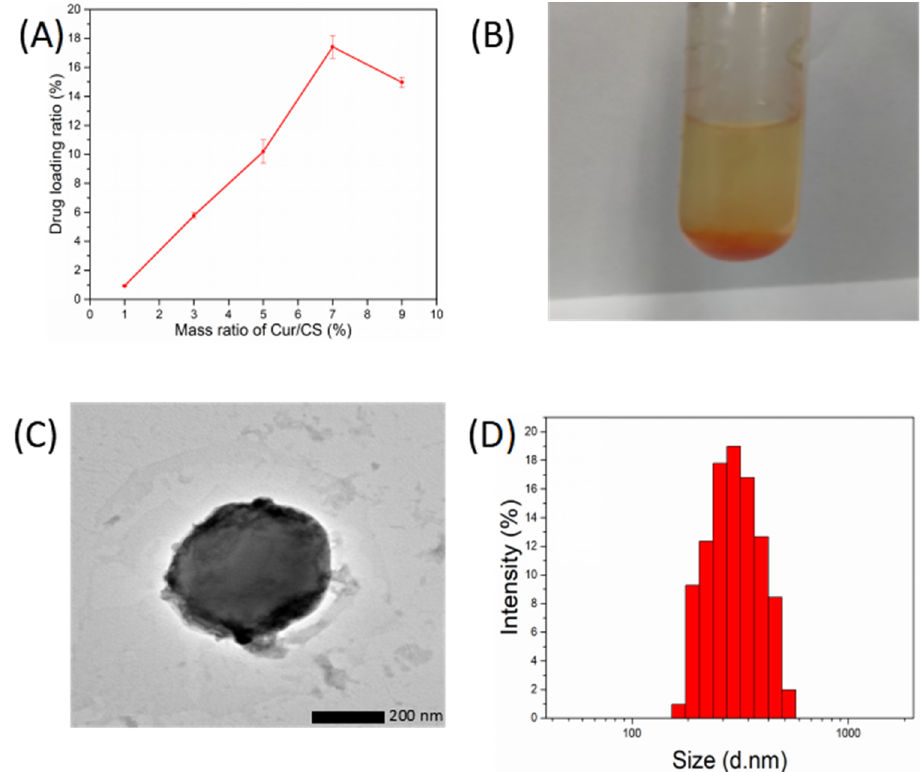
Figure 1. Drug loading ratio of CCNPs ( A ), CCNPs aggregated in distilled water ( B ), TEM images of CCNPs ( C ). size distribution of CCNPs ( D ).